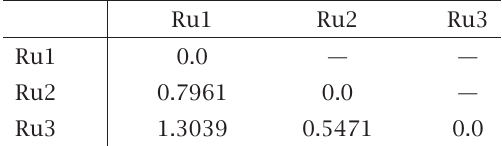
Table 4.1 . Table of